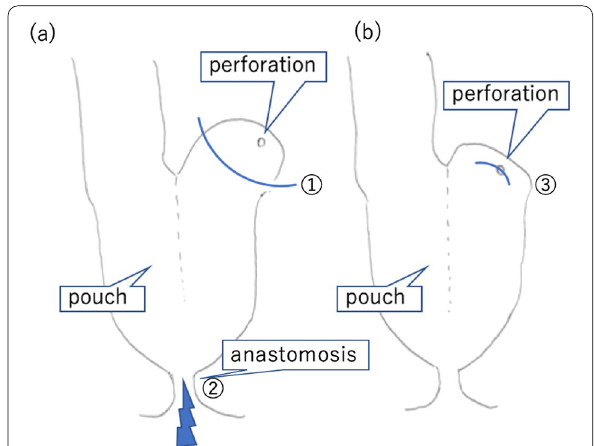
Fig. 2 Schemes of the operation. a Operation during the first perforation. A 2-mm perforation at the top of the pouch was resected using a stapler ① . An anastomotic stricture was observed, and it was manually dilated to 20 mm in diameter ② . b Operation during the second perforation. A 2-mm perforation at the top of the pouch was once again observed and primary repair was performed ③